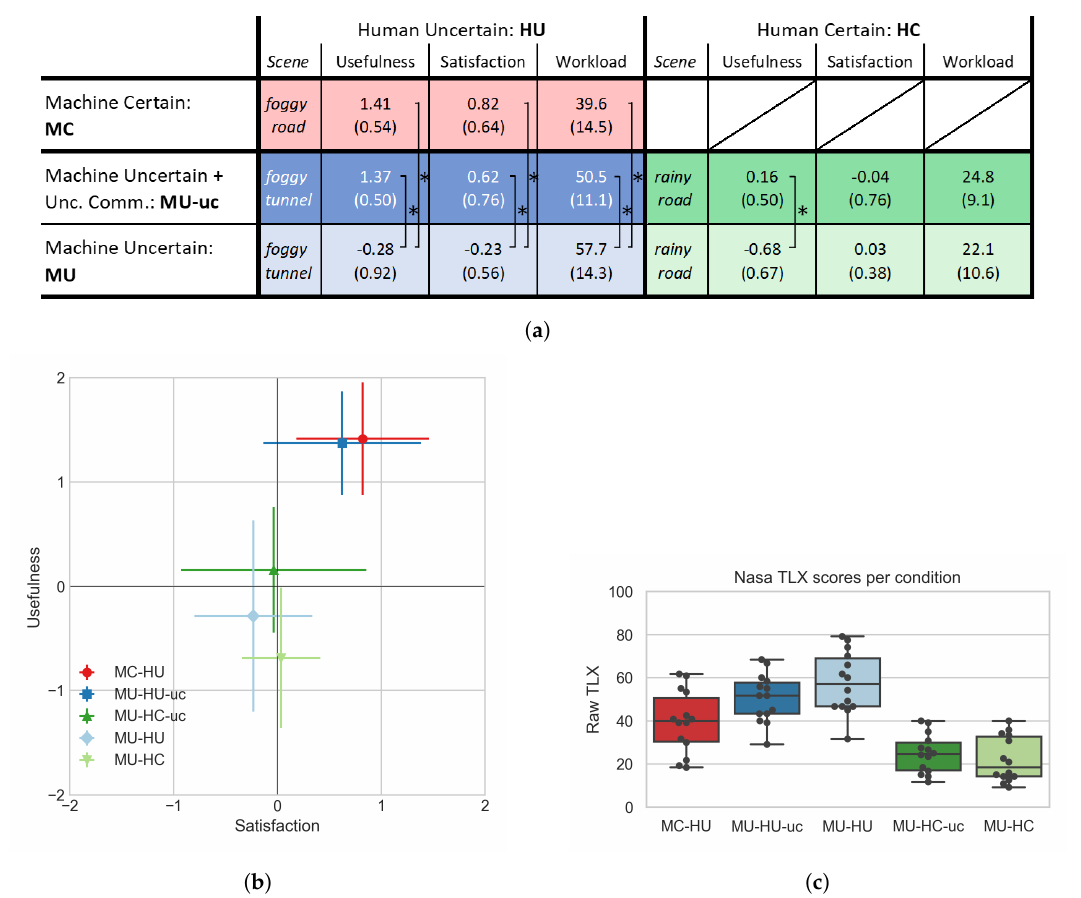
Figure 10. Results of subjective measures for different conditions. Conditions are visually represented by distinct colors. For machine uncertain conditions (blue and green), the light colors mark conditions without uncertainty communication. Their dark counterparts indicate uncertainty communication. ( a ) Mean usefulness, satisfaction, and NASA TLX scores for each condition. Standard deviations are shown in brackets. Asterisks indicate statistically significant differences between conditions linked by brackets; ( b ) Mean usefulness and satisfaction scores of the assistance functionality in MC-HU (Foggy Road), MU-HU-uc (Foggy Tunnel), MU-HC-uc (Rain), MU-HU (Foggy Tunnel, no UC), MU-HC (Rain, no UC). Error bars display the standard deviation; ( c ) NASA Raw TLX scores per condition. Scores of individual questions were averaged to obtain the overall RTLX score in the range